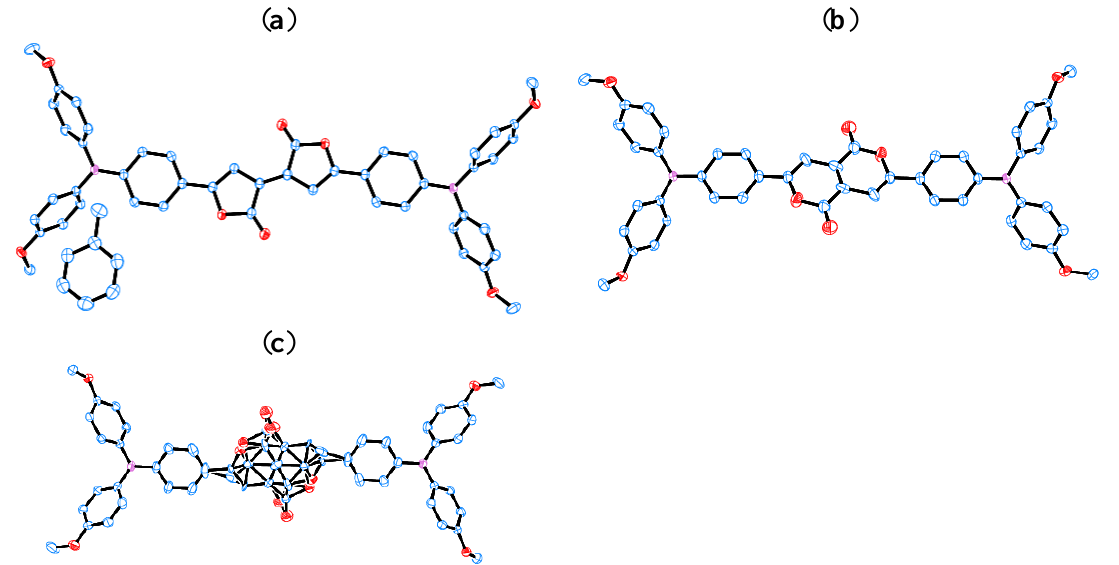
Figure 21. ORTEP drawings of ( a ) P ellipsoids set at the 50% probability level. P Hydrogen atoms are omitted for